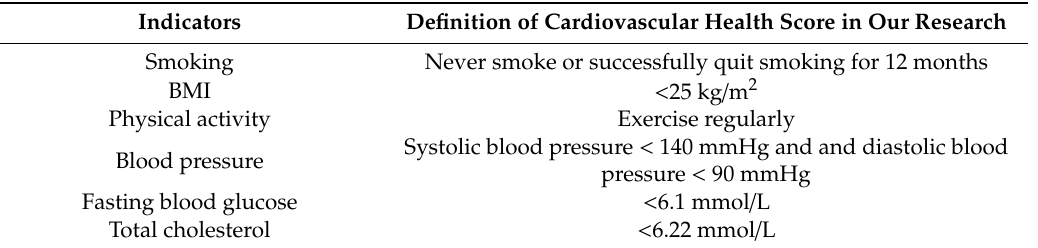
Table 1. Definition of cardiovascular health score in our